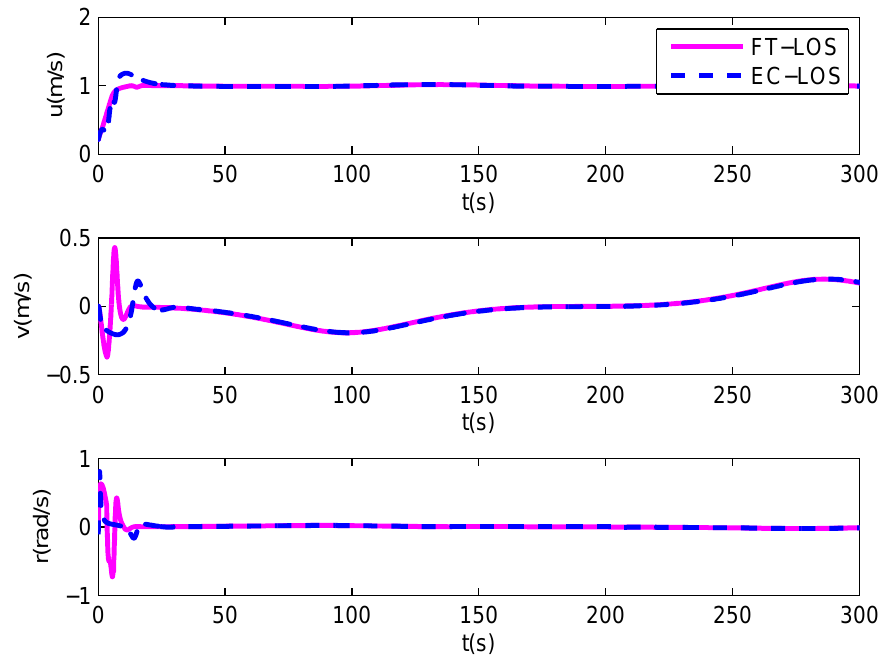
Figure 5. The surge velocity, sway velocity and yaw angle velocity of the underactuated